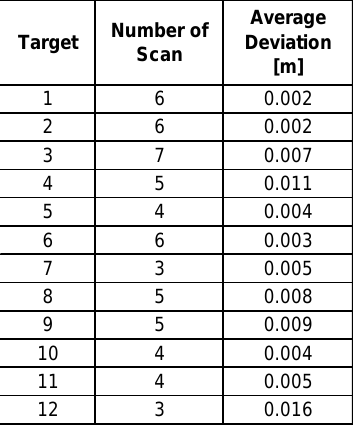
Table 1. Average deviation of the target in Target-Based registration